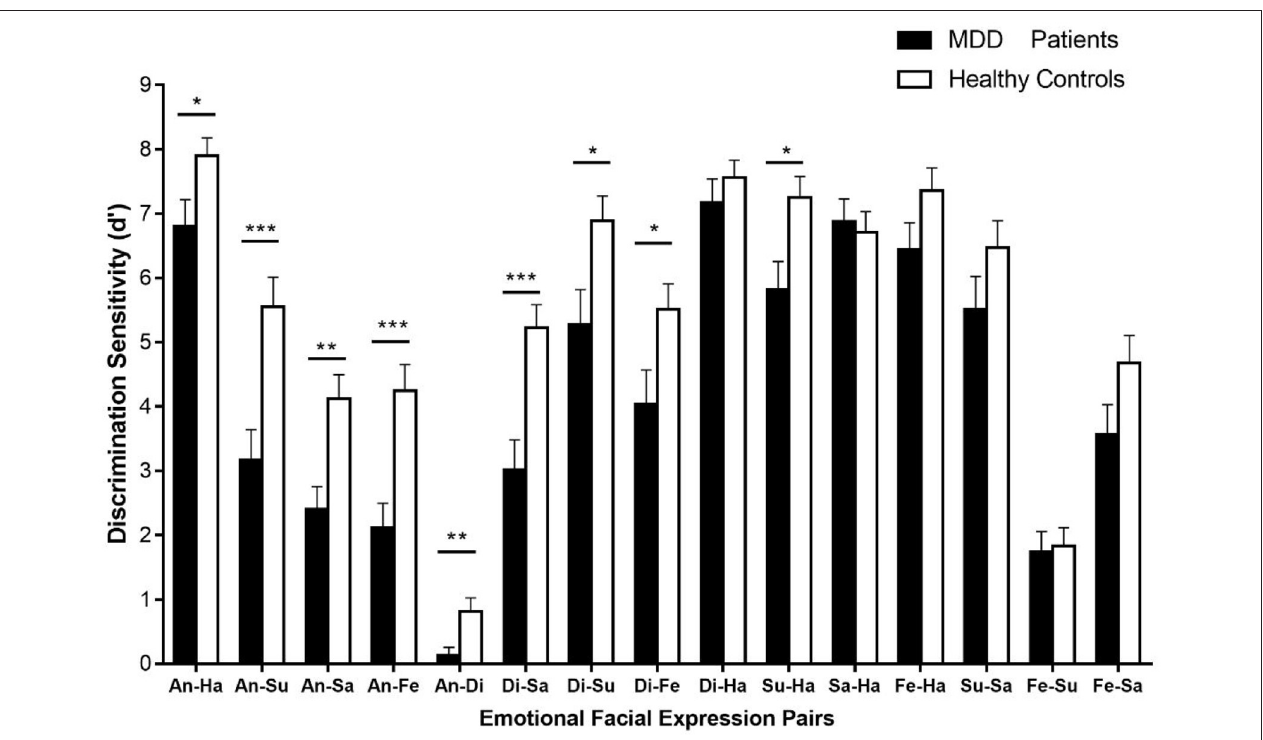
FIGURE 2 | The discrimination sensitivities (d ′ ) for 15 emotional facial expression pairs. Error bars represent SEMs. Di, disgust; An, anger; Fe, fear; Su, surprise; Sa, sadness; Ha, happiness. * p < 0.05; ** p < 0.01; *** p < 0.001.